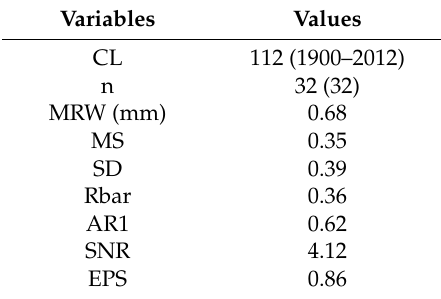
Table 3. Dendrochronology related descriptive statistics used to evaluate the quality of the chronology in our study.